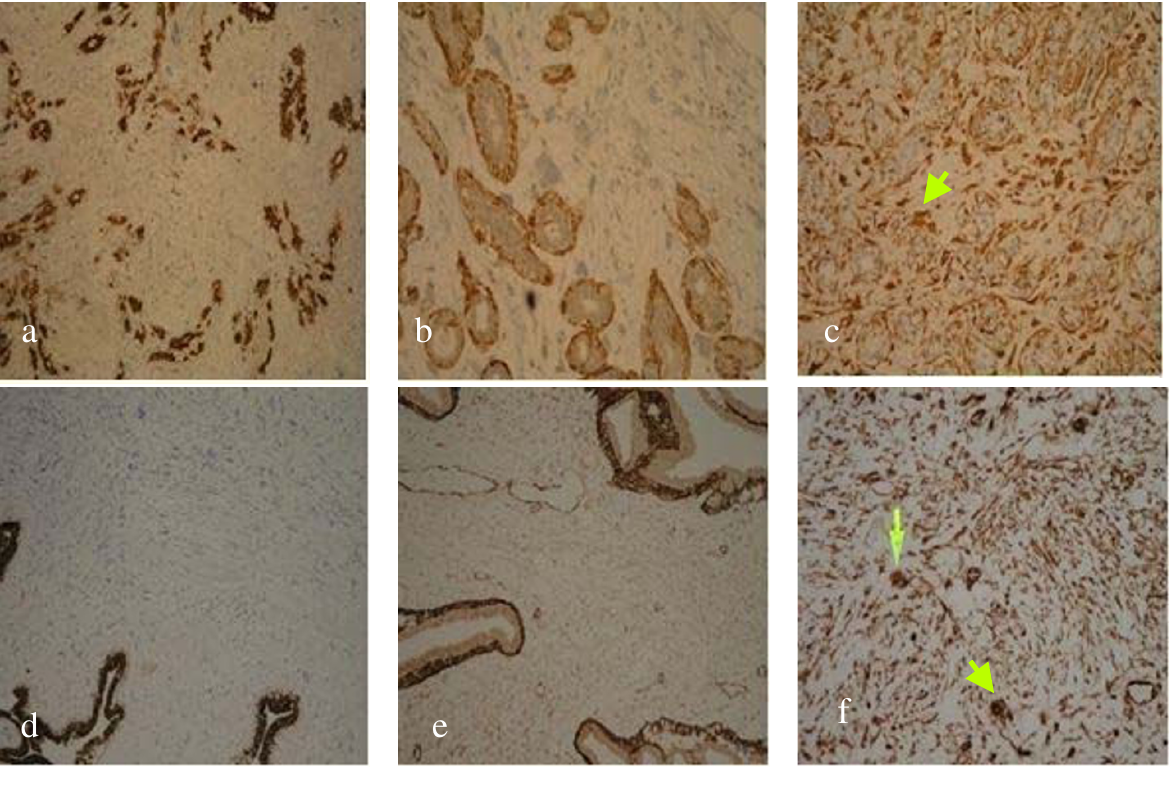
Figure 3 Immunohistochemical stains on core breast biopsy tissue . a. Case 1: Pancytokeratin. b. Case 1: SMA. c. Case 1: Vimen- tin (arrow marks multinucleated giant cells in stroma). d. Case 2: Pancytokeratin. e. Case 2: SMA. f. Case 2: Vimentin (arrow marks multinucleated giant cells in